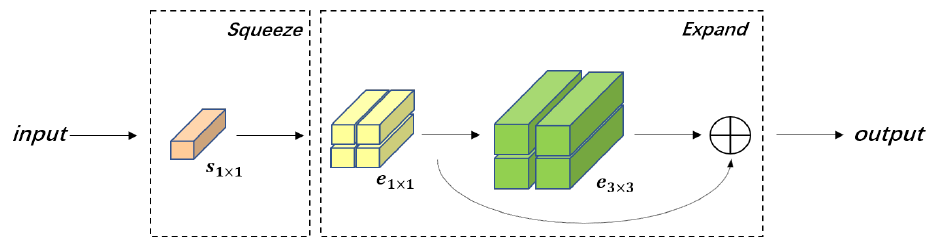
Figure 3. The structure of SqueezeNet. The last 2 layers are to fine-tune the model, which do not appear in the initial training. So, we use a dotted box to represent the last 2 layers.